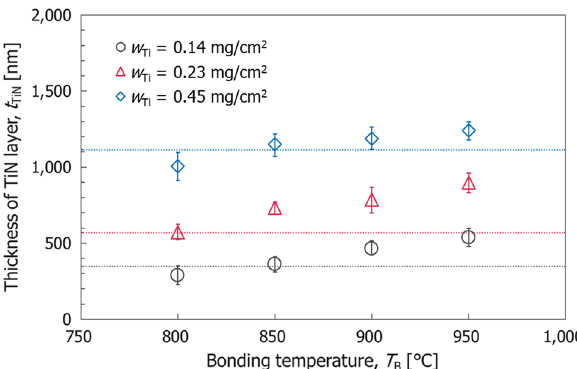
Fig. 4 TiN layer thickness at Cu/AlN interface versus bonding temperature. The dotted lines correspond to the TiN layer thickness estimated from the amount of